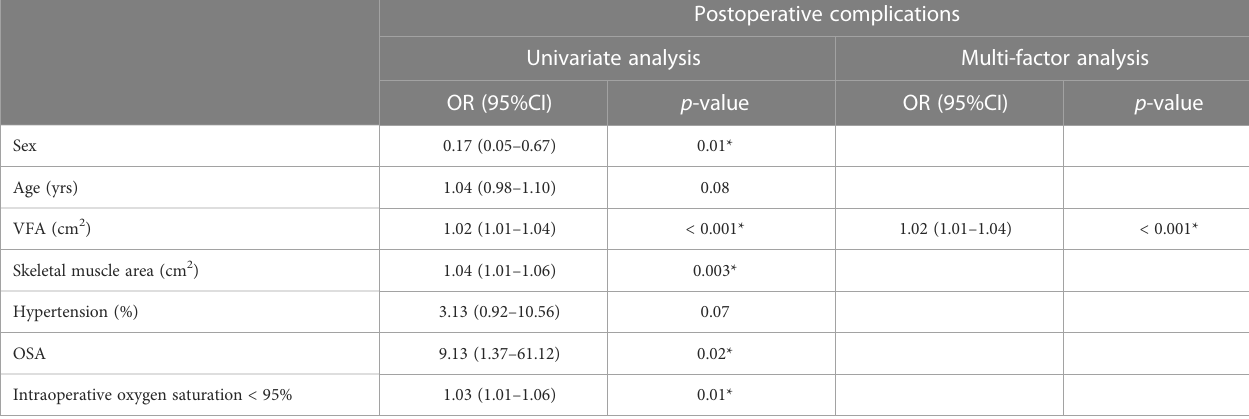
TABLE 3 Univariate and multivariate analysis of factors associated with postoperative complications.